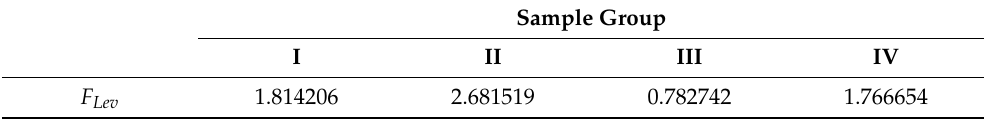
Table 6. Levene test